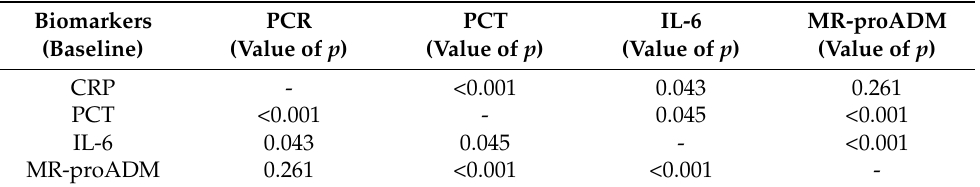
Table 6. Correlation between C-reactive protein, procalcitonin, Interleukin-6 and Midregional-pro-